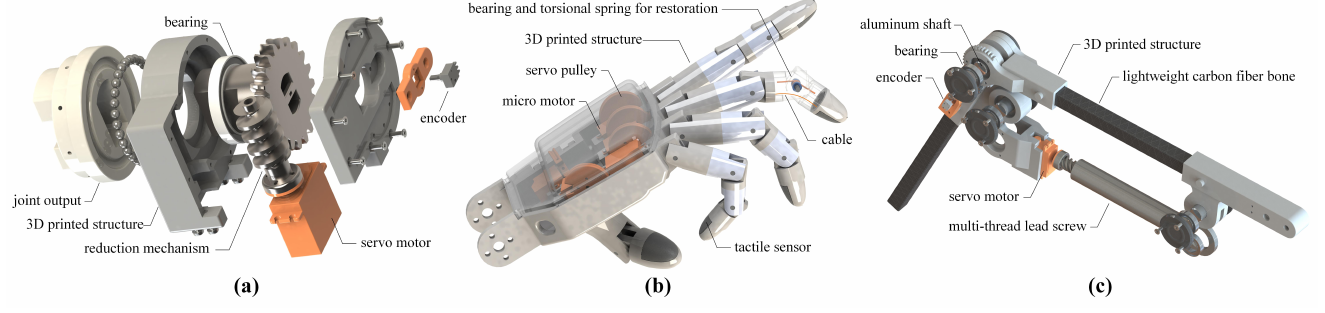
Figure 4. Detailed design in terms of ( a ) the lightweight drive unit of joint C in the right shoul- der, ( b ) the compact and self-consistent end effector, and ( c ) the supporting structure and driving mechanism in the